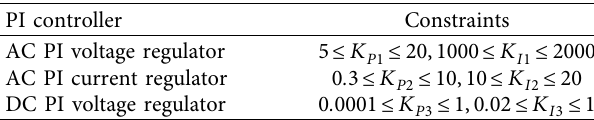
Table 2: STATCOM PI gain constraints